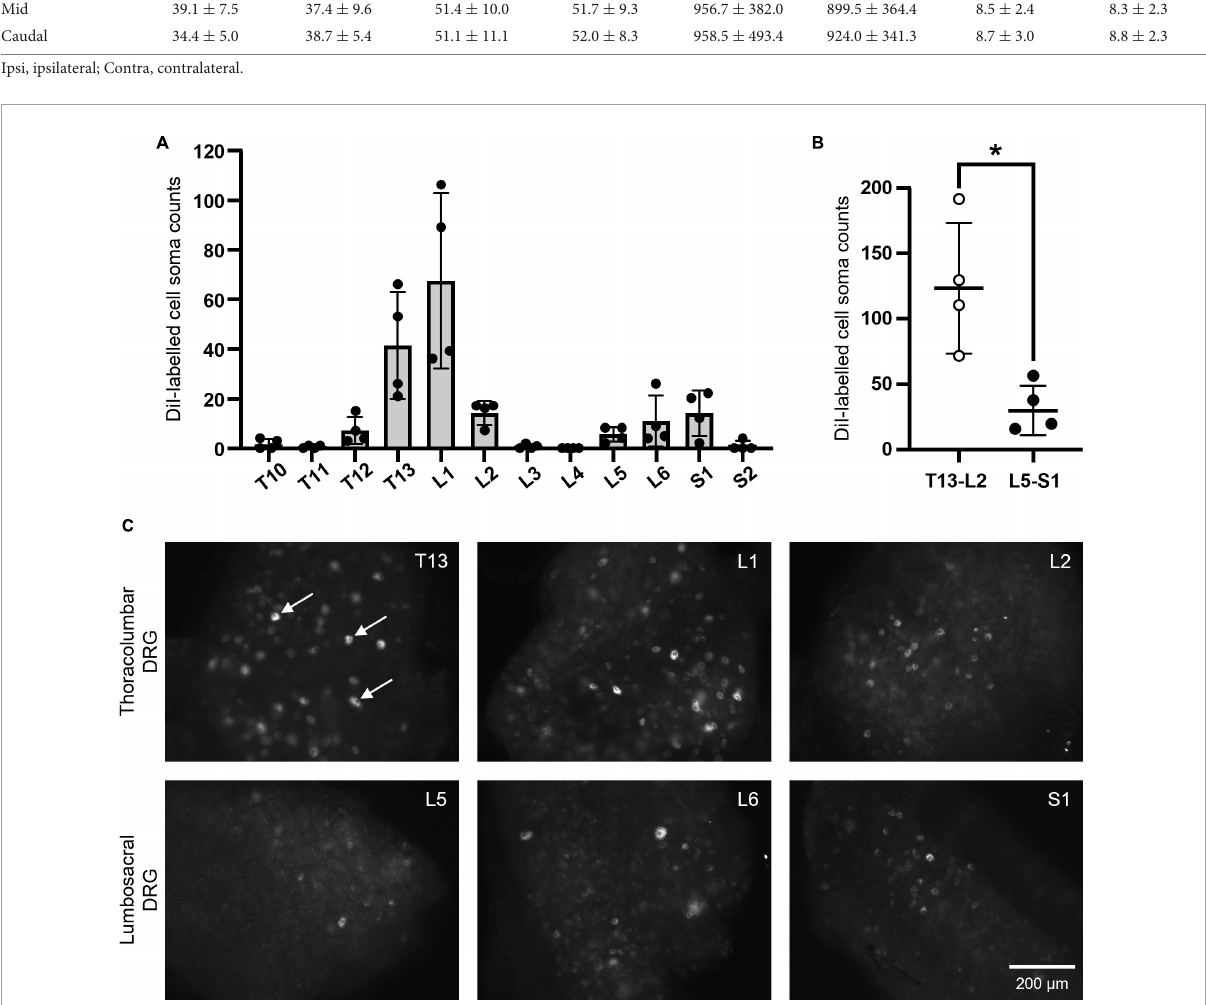
FIGURE3 DiI-labeled somata in thoracolumbar and lumbosacral DRG following retrograde neuronal tracing from the caudal mouse uterine horn. (A) Summary data showing the distribution of n = 660 positively labeled cell soma counts across T10-S2 DRG ( N = 4). (B) Combined values from thoracolumbar T13-L2 and lumbosacral L5-S1, demonstrating that thoracolumbar spinal afferents supply significantly greater innervation to the caudal uterine horn compared to lumbosacral spinal afferents ( P = 0.0442; paired, two-tailed t test). (C) Representative images of somata that were retrogradely-labeled with DiI in thoracolumbar T13-L2 DRG (upper row) and lumbosacral L5-S1 DRG (lower row). Examples of somata considered to be positively labeled in the given focal plane are indicated by the arrows in panel T13 (C) . Scale bar in panel S1 (C) applies to all images. DRG, dorsal root